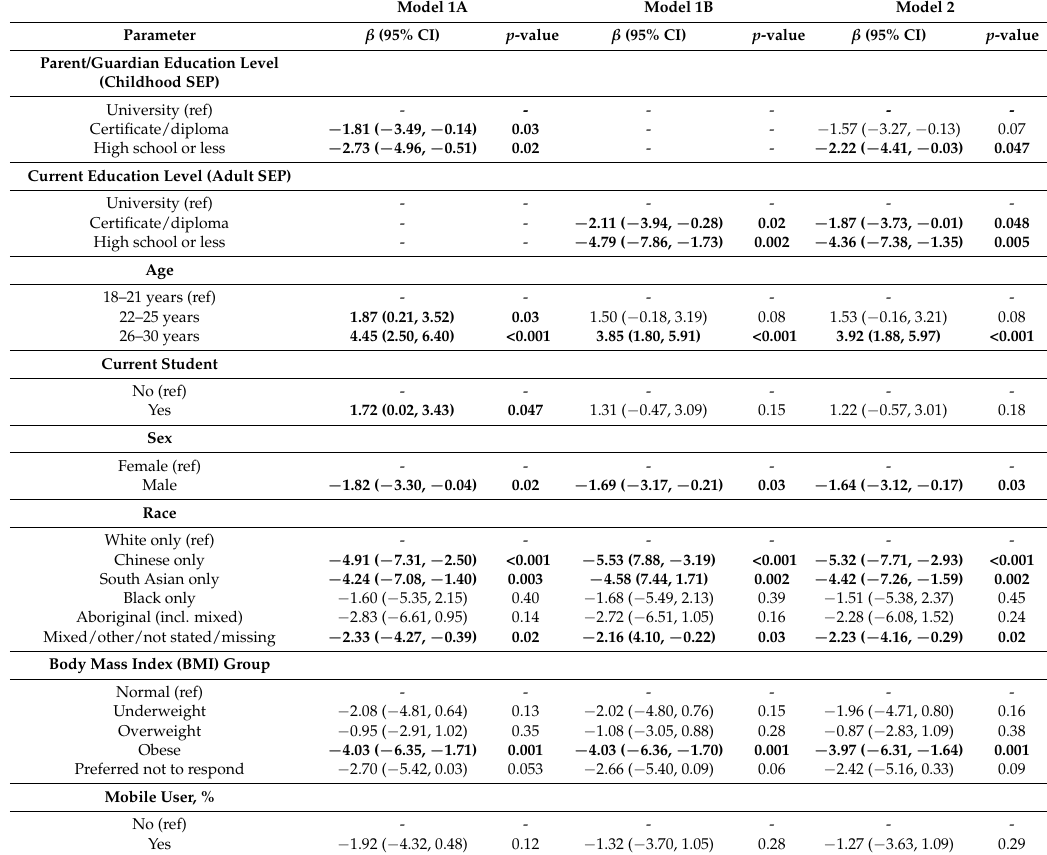
Table 3. Multivariable associations (adjusted) between socioeconomic position (SEP) in childhood and young adulthood with Healthy Eating Index-2015 (HEI-2015) scores in young